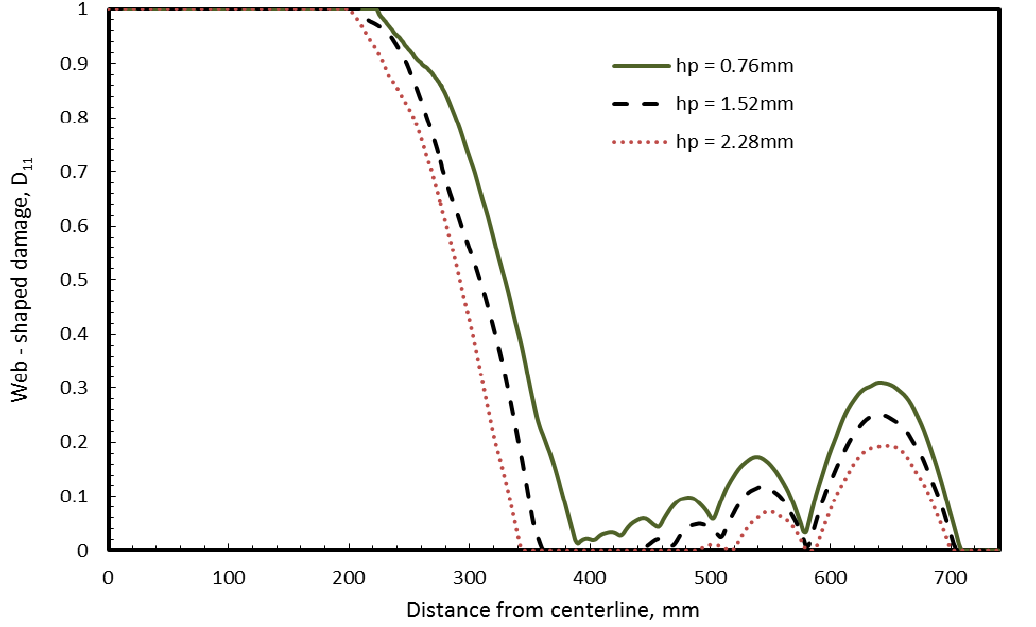
Figure 9. Effect of PVB interlayer thickness on web-shaped damage, D large missile (round end)